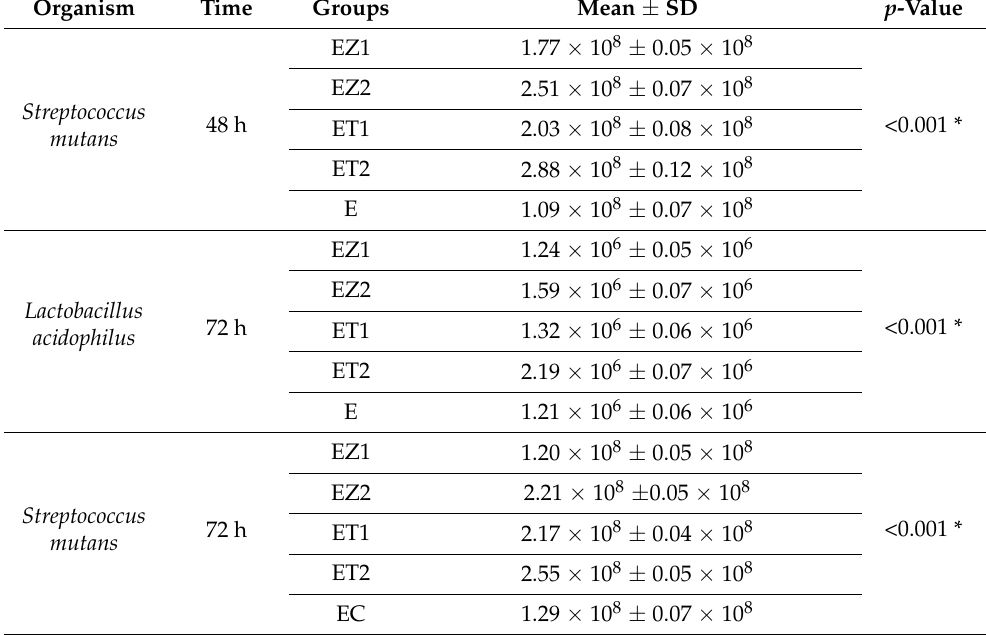
Table 2. Cont. Organism Time Groups Mean ± SD p -Value